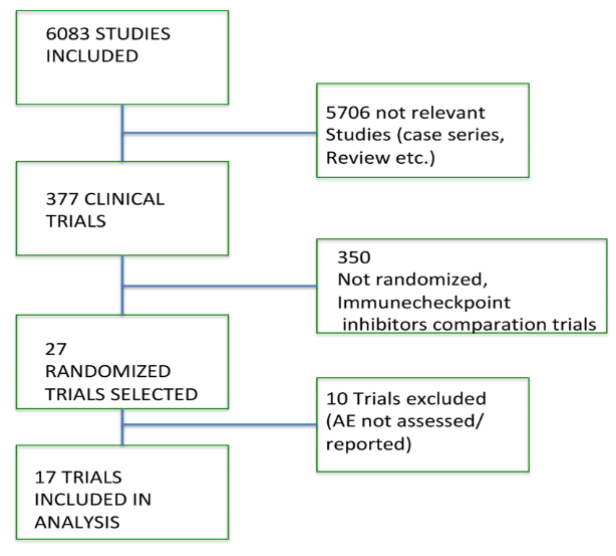
Figure 1. Studies screened and included in our meta-analysis.